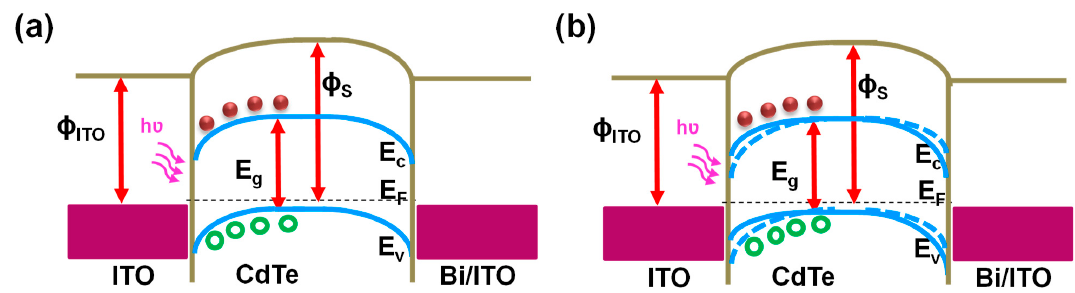
Figure 8. Schematic band diagrams of a CdTe microdots photodetector under ( a ) normal conditions and ( b ) with stress under illumination to illustrate the working mechanism of Piezo-phototronic effect-enhanced Photodetector performance.